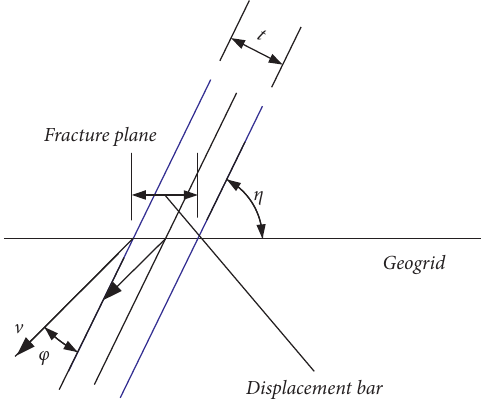
Figure 15: Schematic diagram of reinforcement failure.